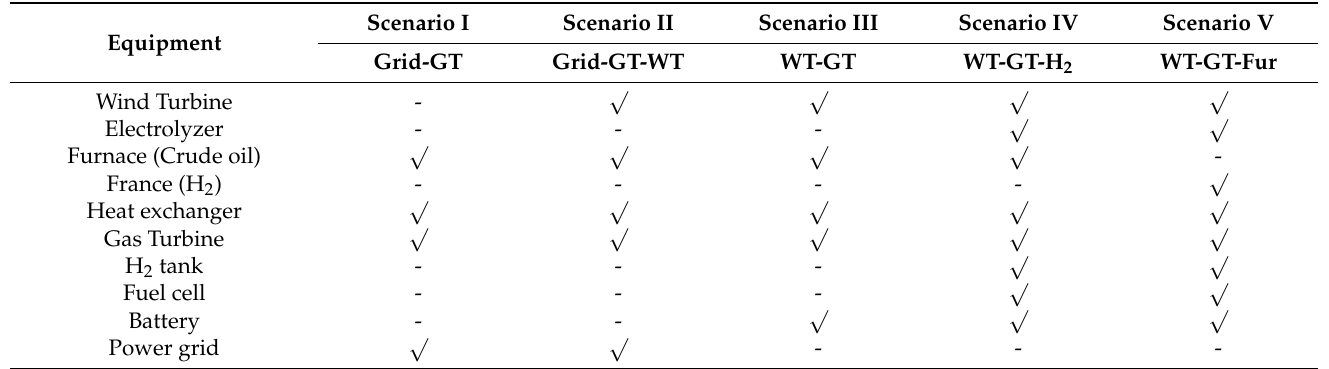
Table 2. Scenarios for production, transportation, and storage of energy.